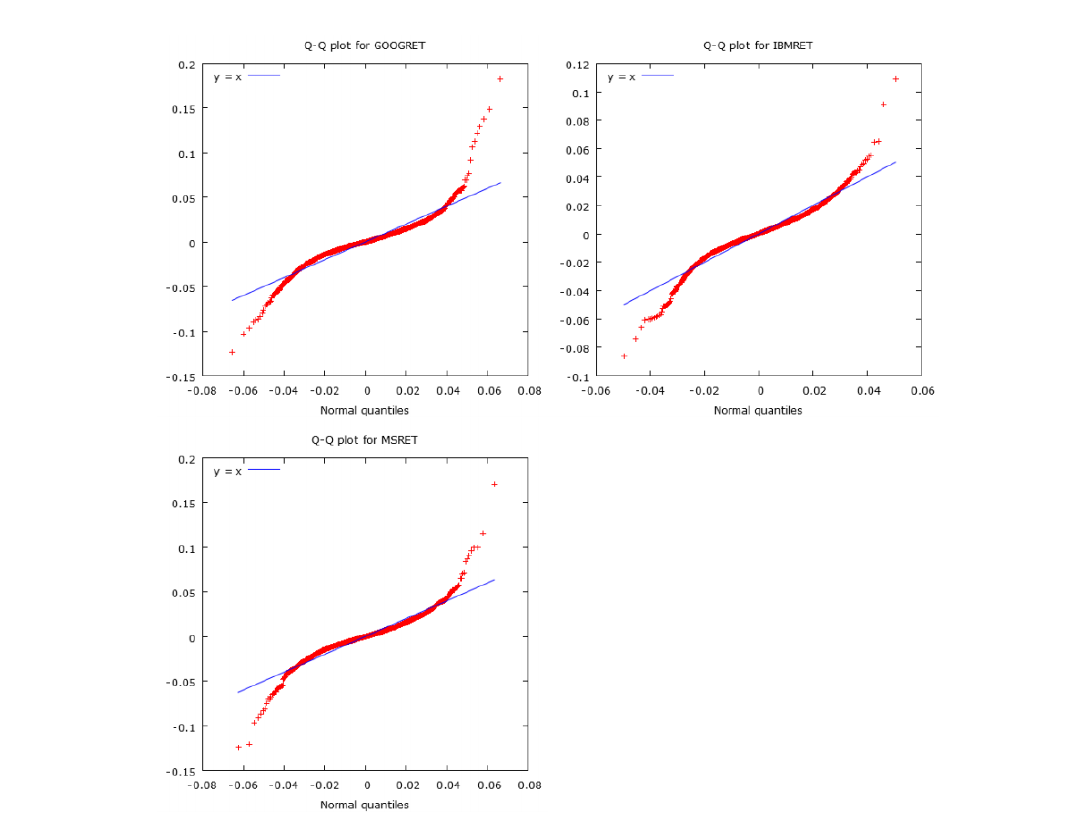
Figure 2. QQplots of return